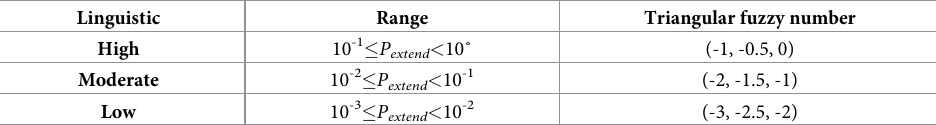
Table 10. Linguistic variables that present three propagation levels to the fuzzy